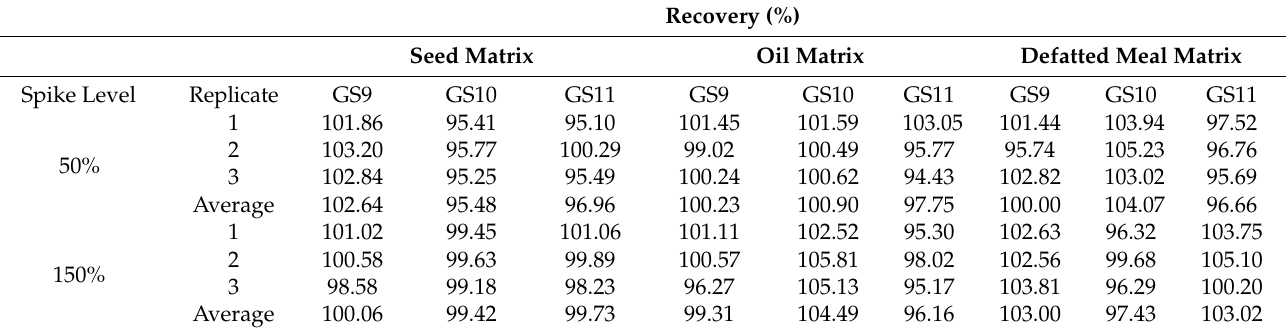
Table 4. Recovery percentages of accuracy test data in placebo samples (canola seeds, oil, and defatted meal). Recovery